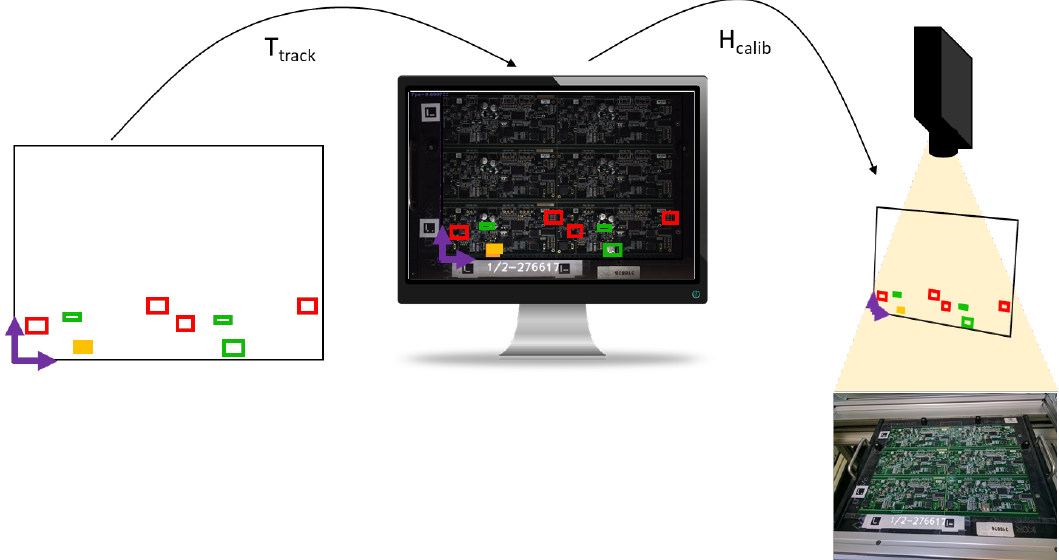
Figure 5. Conceptual scheme of the projection mapping pipeline. Virtual content (left) is transferred to the camera image ( T track ), and then, this content is transformed again ( H calib ) to the projector image area that is subsequently projected. See text for details.